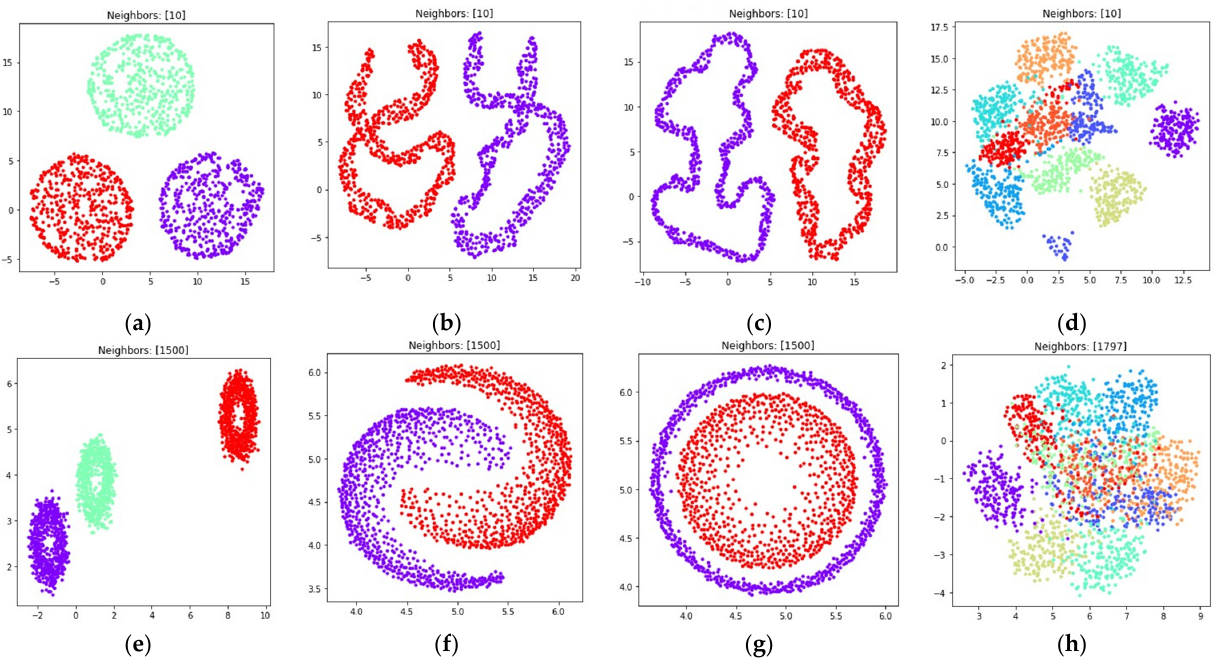
Figure 6. Locations of objects in R 2 with dimensionality reduction performed by applying the UMAP algorithm, with low dimensional embedding optimized by the Adam algorithm and the gradient (32) with d min set to 1 for: ( a ) blobs, k = 10; ( b ) moons, k = 10; ( c ) circles, k = 10; ( d ) handwritten digits, k = 10; ( e ) moons, k = ( n − 1 ) ; ( f ) blobs, k = ( n − 1 ) ; ( g ) circles, k = ( n − 1 ) ; ( h ) handwritten digits, k = ( n − 1 ) .